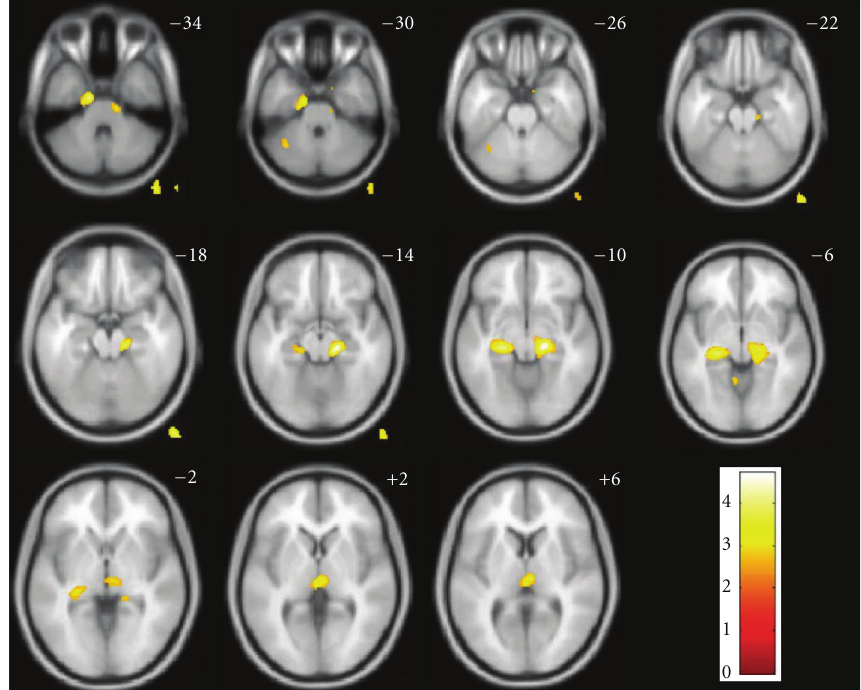
Figure 1: SPM8 maps of voxel-based correlations between [ 11 C]PIB tracer uptake and CSF BACE1 activity. Anatomical localization as projected on axial sections of a normal T1-weighted MRI, spatially normalized into the MNI template at the given z coordinates in Talairach’s space ( P < 0 . 01 uncorrected for display purposes; voxels outside of the brain and in the cerebellum are artifacts due to this threshold); color bars represent Z -scores; images are displayed in neurological orientation (right side is